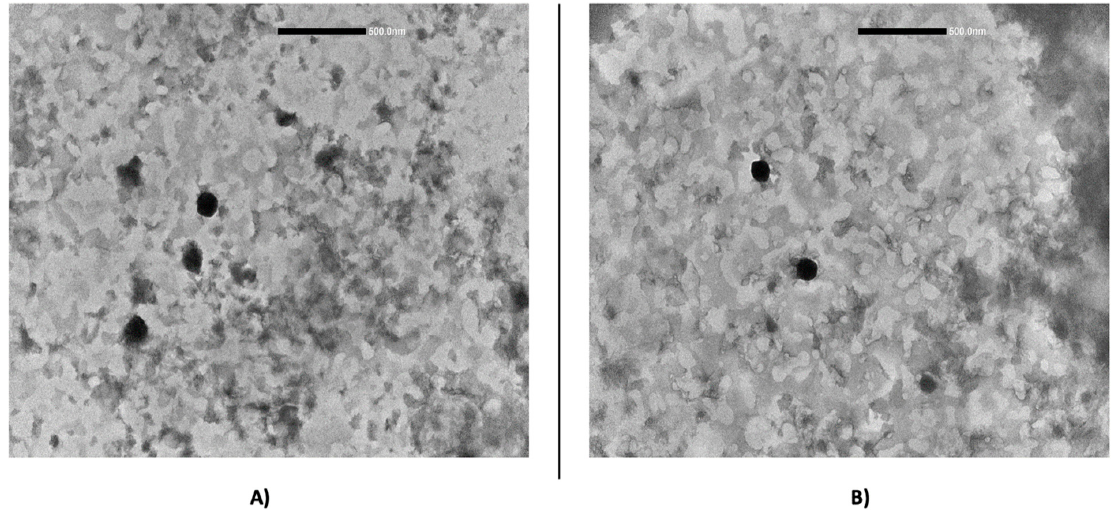
Figure 1. TEM micrograph of 8-MOP-loaded SLN TRC 0% ( A ) and SLN TRC 2% ( B ).